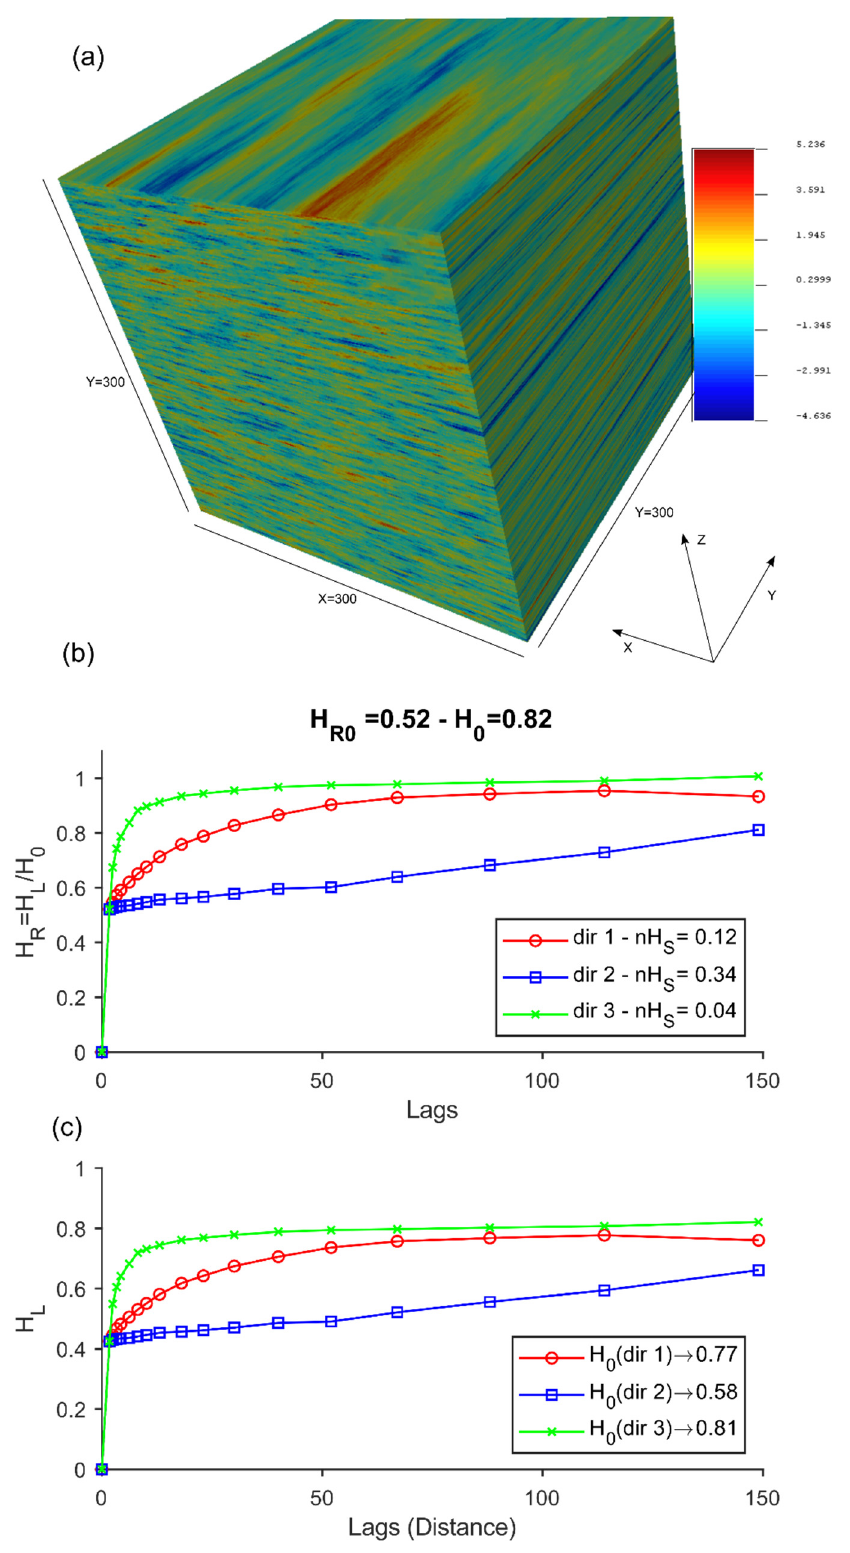
Figure 4. ( a ) A 3D (300 × 300 × 300 voxels) anisotropic sequential Gaussian simulation generated using SGEMS; ( b , c ) entrograms with normalised and non-normalised directions, respectively, of